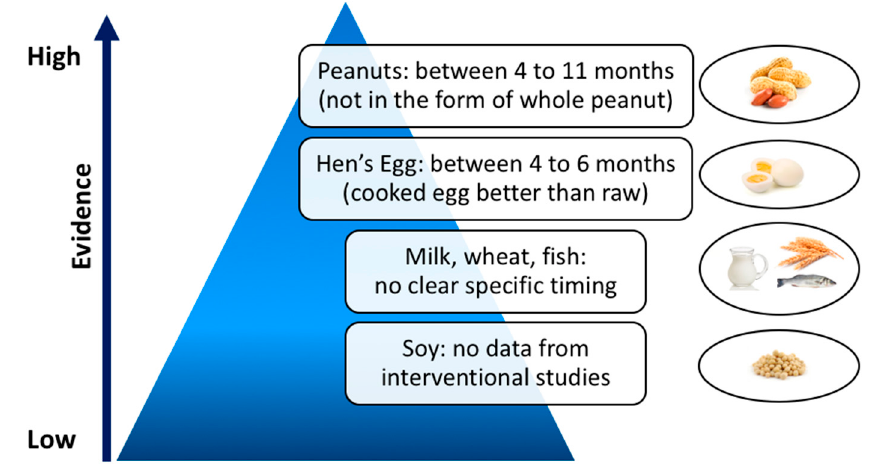
Figure 1. Timing of food introduction into infant diet and corresponding level of evidence.